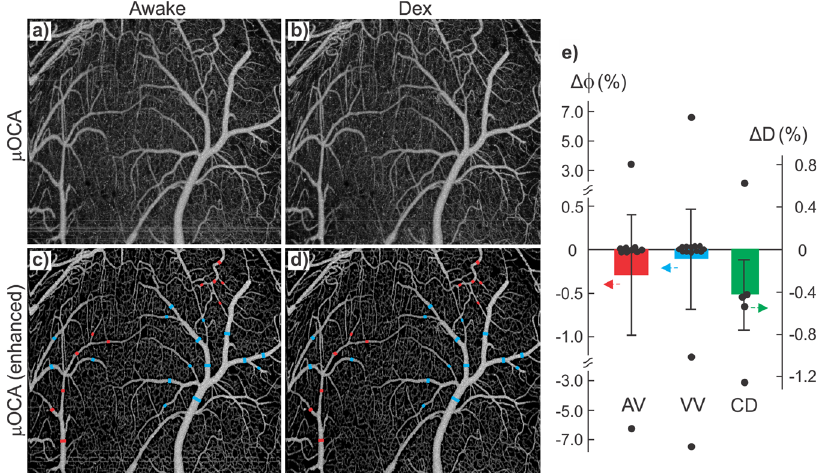
Fig. 5 3D μ OCA images of mouse sensorimotor cortex in awake vs Dex-anesthetized states. a , b Raw μ OCA images of awake vs Dex states; c , d Their corresponding enhanced μ OCA images by deep-learning processing; e statistical analyses of Dex-induced size changes in arteriolar vessels (AV), venular vessels (VV) and capillary density (CD). Image size: 2.3 × 1.2 × 2 mm 3 . Red and blue bars represent arteriolar and venular vessel size changes ( Δϕ ) respectively; the green bar represents the capillary density change ( Δ D) with Dex.